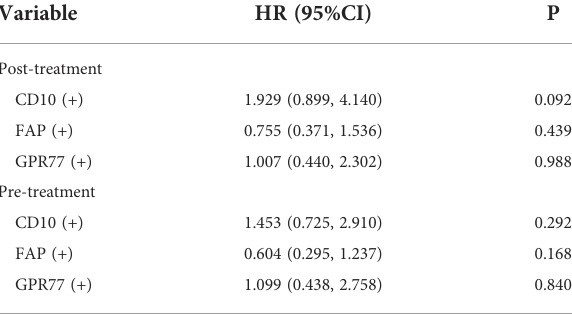
TABLE 5 Multivariable analysis for overall